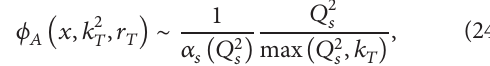
Figure 3: Hybrid model simulation for the eccentricity-scaled ellip- /𝑑𝑦) , for tic flow V 2 /𝜖 as a function of multiplicity density (1/𝑆)(𝑑𝑁 ch .Eccentricity-scaledellipticflowdoesnot differentvaluesof (𝜂/𝑠) QGP depend on the details of the model for initial density distribution but only on the QGP viscosity. See [57] for